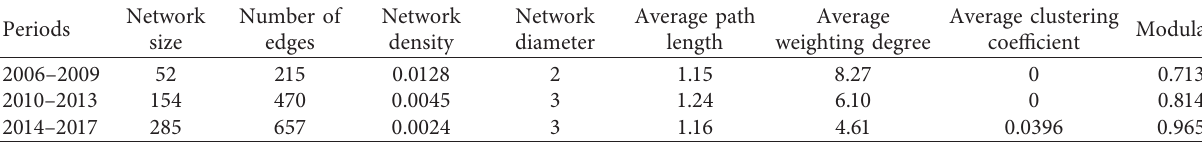
Table 1: Topological structure indicators of NEVs coinvention